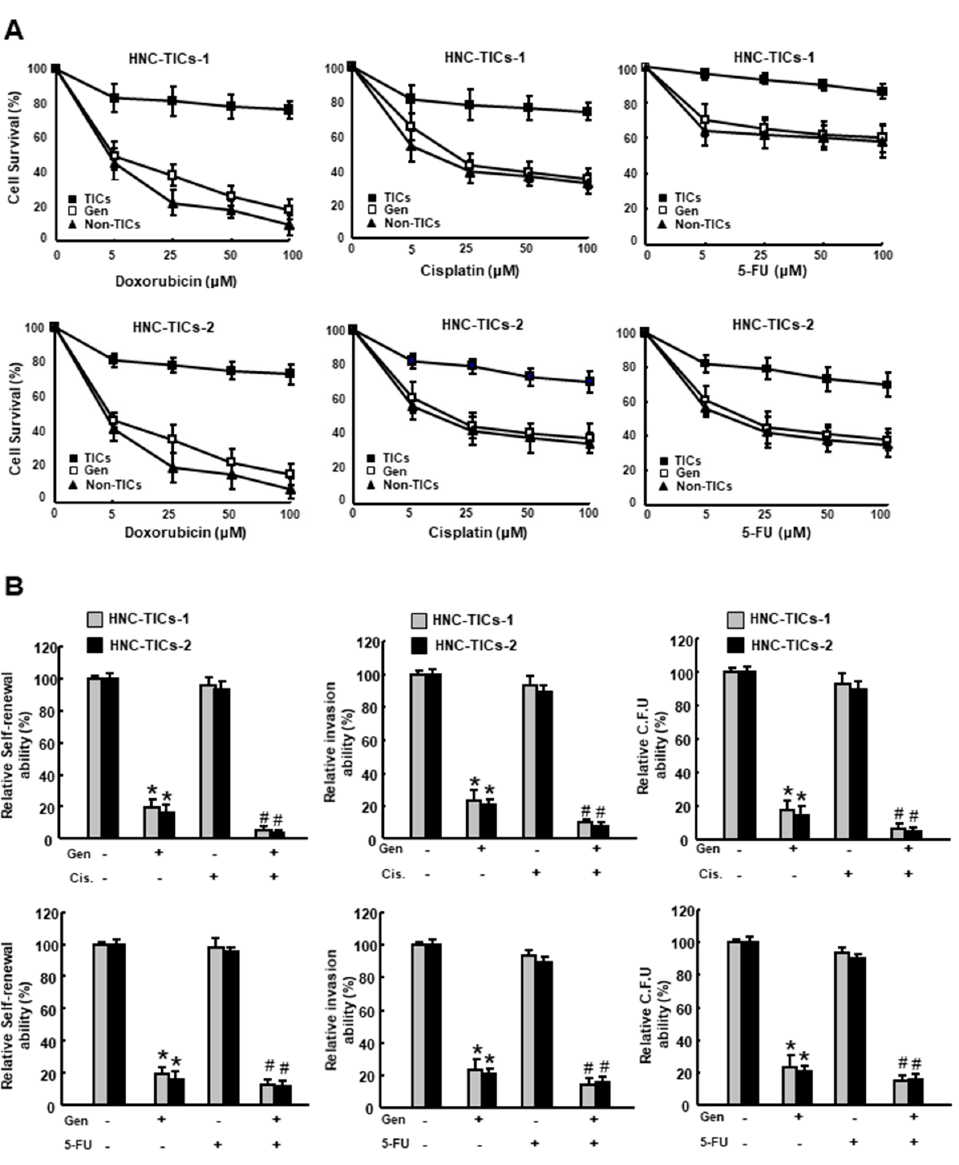
Figure 3. ( A ) Cell survival in response to multiple chemotherapies of non-TICs (non-tumor-initiating cells), TICs (tumor-initiating cells) and TICs treated with genistein (20 µ M) using two HNC-TICs (tumor-initiating cells of head and neck cancers) was tested using MTT assay; ( B ) Self-renewal ability following treatment of genistein (Gen) with or without Cisplatin (Cis.) / 5-Fluorouracil (5-FU). * p < 0.05 compared to control group. # p < 0.05 compared to genistein only group.